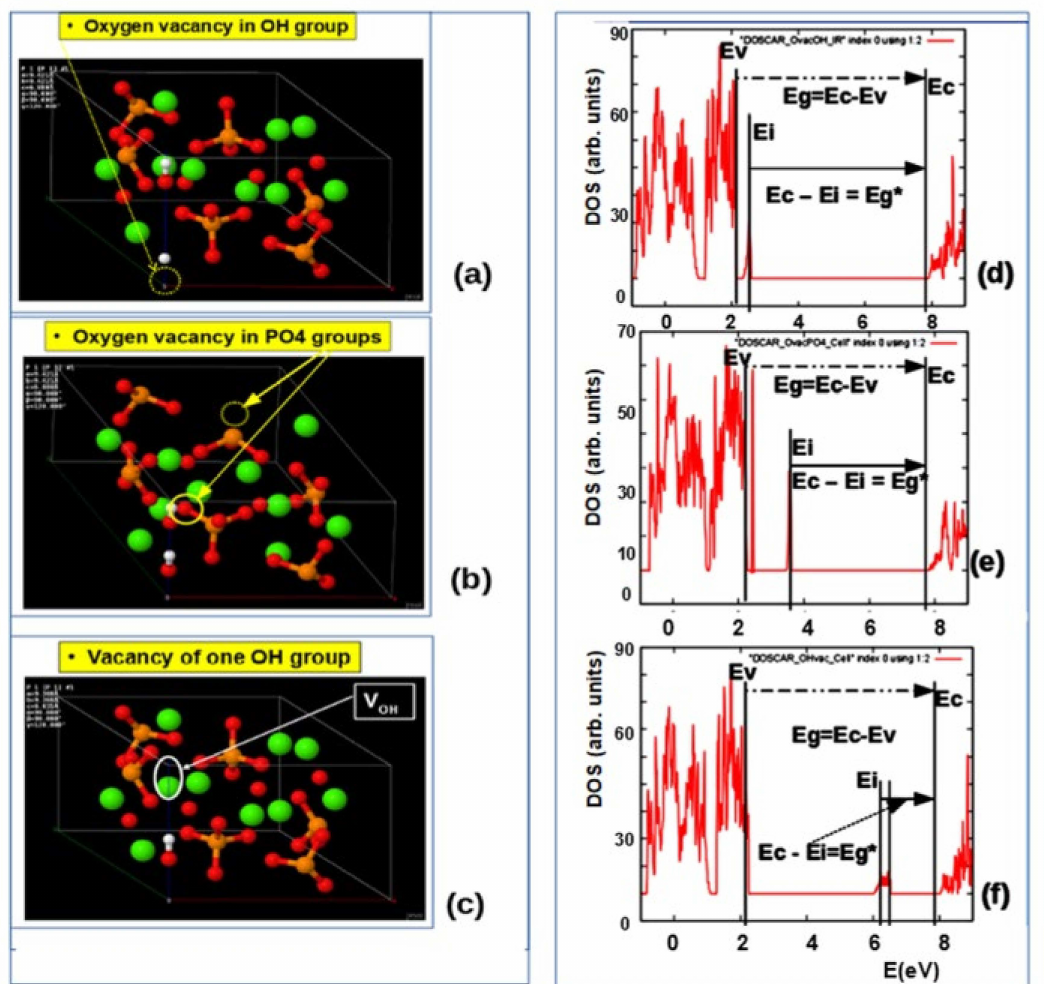
Figure 6. Density of electronic states (DOS) for HAP unit cell with defects: ( a ) HAP unit cell model with O vacancies from the OH group; (b ) HAP unit cell model with O vacancies from the PO 4 groups (this may be with O atom from different positions); ( c ) full vacancy of the OH group from HAP unit cell model; ( d ) DOS for case of the O vacancy in OH group; ( e ) DOS for case of the O vacancy in PO 4 group; ( f ) DOS for case of the full OH vacancy. (Data presented here obtained by calculations firstly using AIMPRO (LDA) [5,6,38] and then VASP (GGA) [39], similar to our works [4–8]). (Adapted with permission from [5]; IOP Publishing,